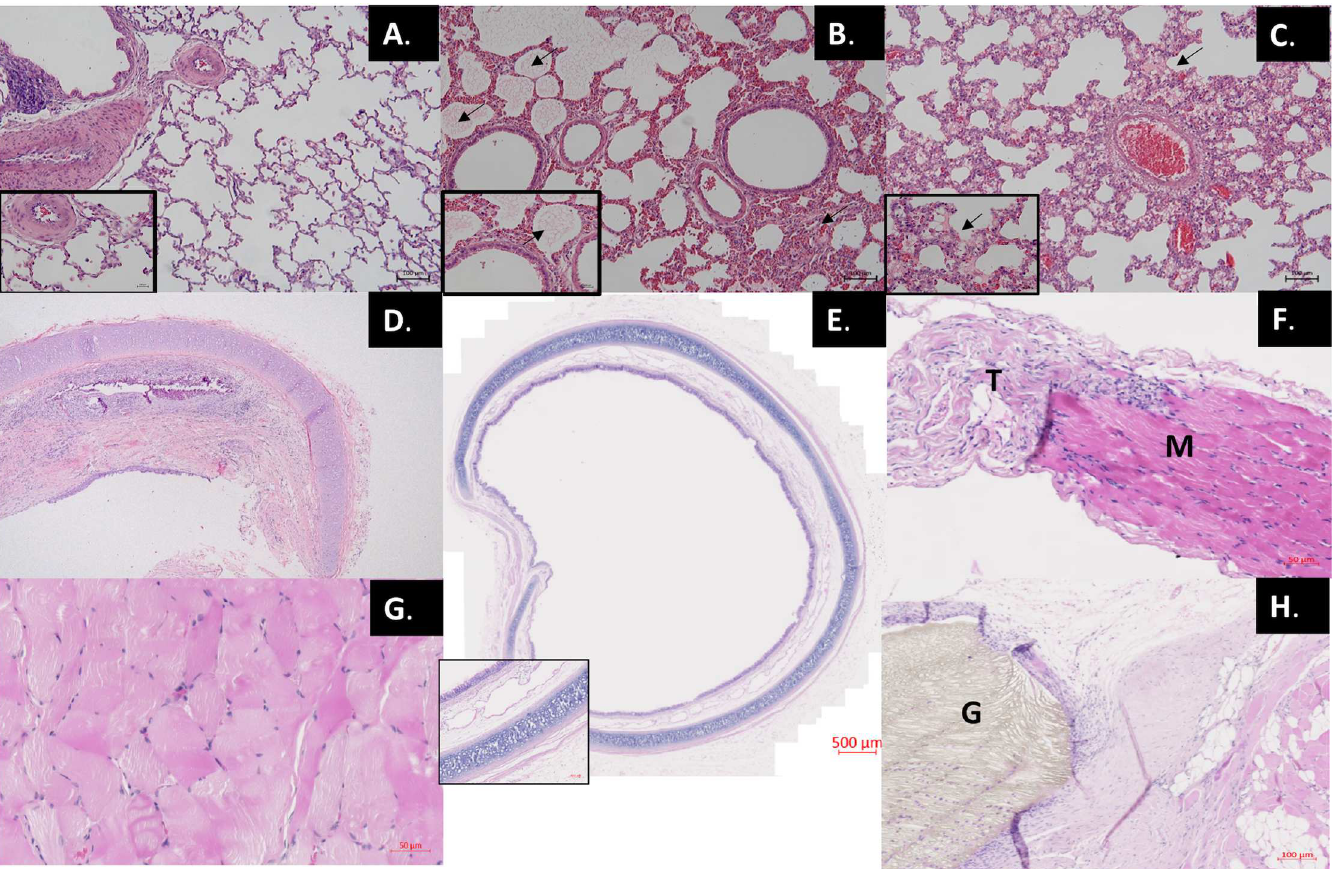
Fig 3. Lung, tracheal and diaphragmatic histology. A. D2: normallung pathologyfollowinga liver haemorrhage (control). B. D16: alveolarand interstitial odema (arrows) followingETT intubation.C. D14: evidenceof hyalinemembraneformation followingETT intubation.D. D33: Trachealstricture